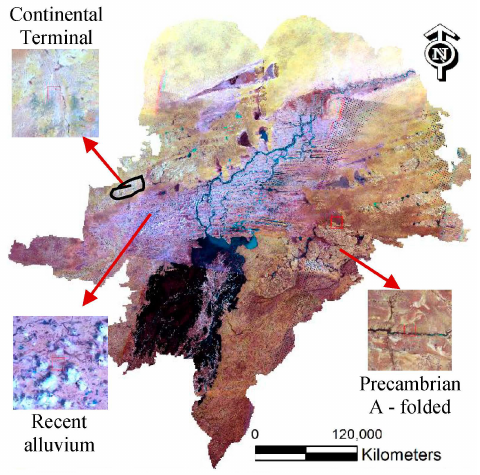
Figure 3. Spectral enhancement of the composite color image (2, 4,